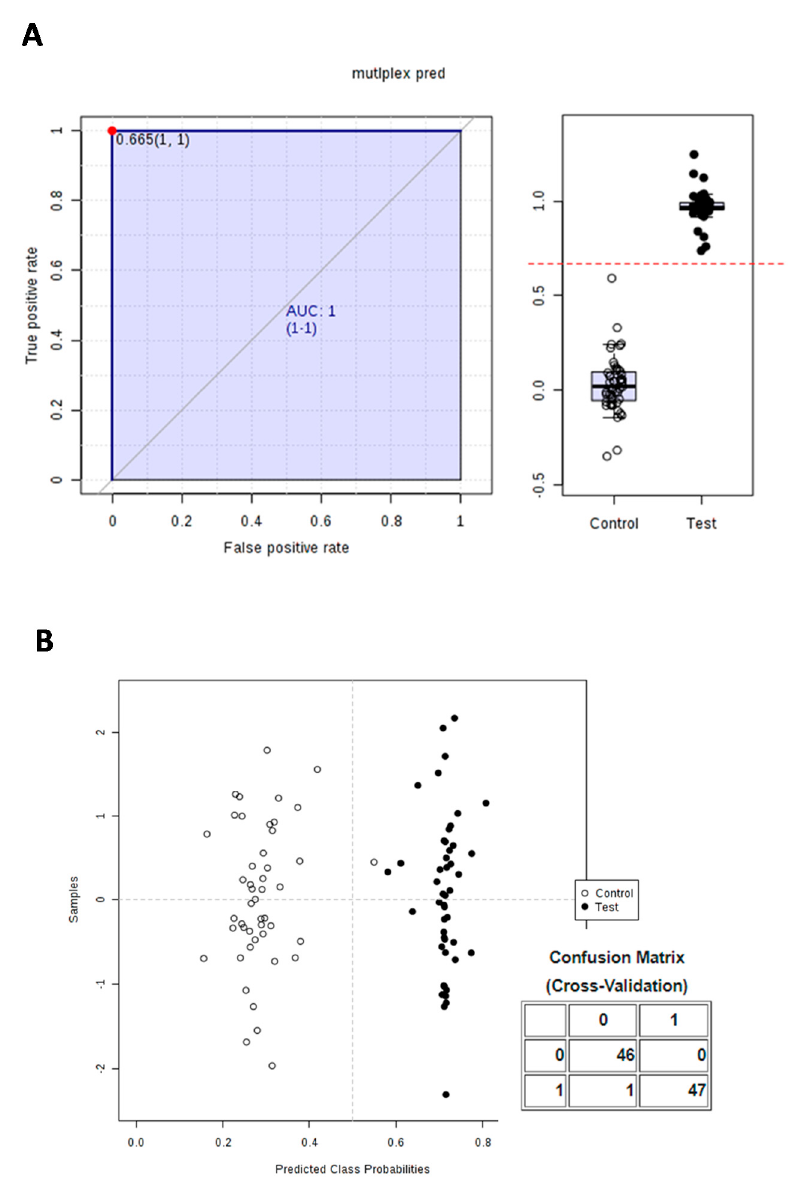
Figure 6. ROC curve analysis. ( A ) Diagram of two components (control and test) with excellent value (AUC = 1; CI=1 − 1 ), cross ‐ validations and result expressed as averaged to generate the plot. ( B ) Predicted class probabilities calculated from the ROC curve, along with the confusion matrix obtained after cross ‐ validation and showing only one misclassified individual.